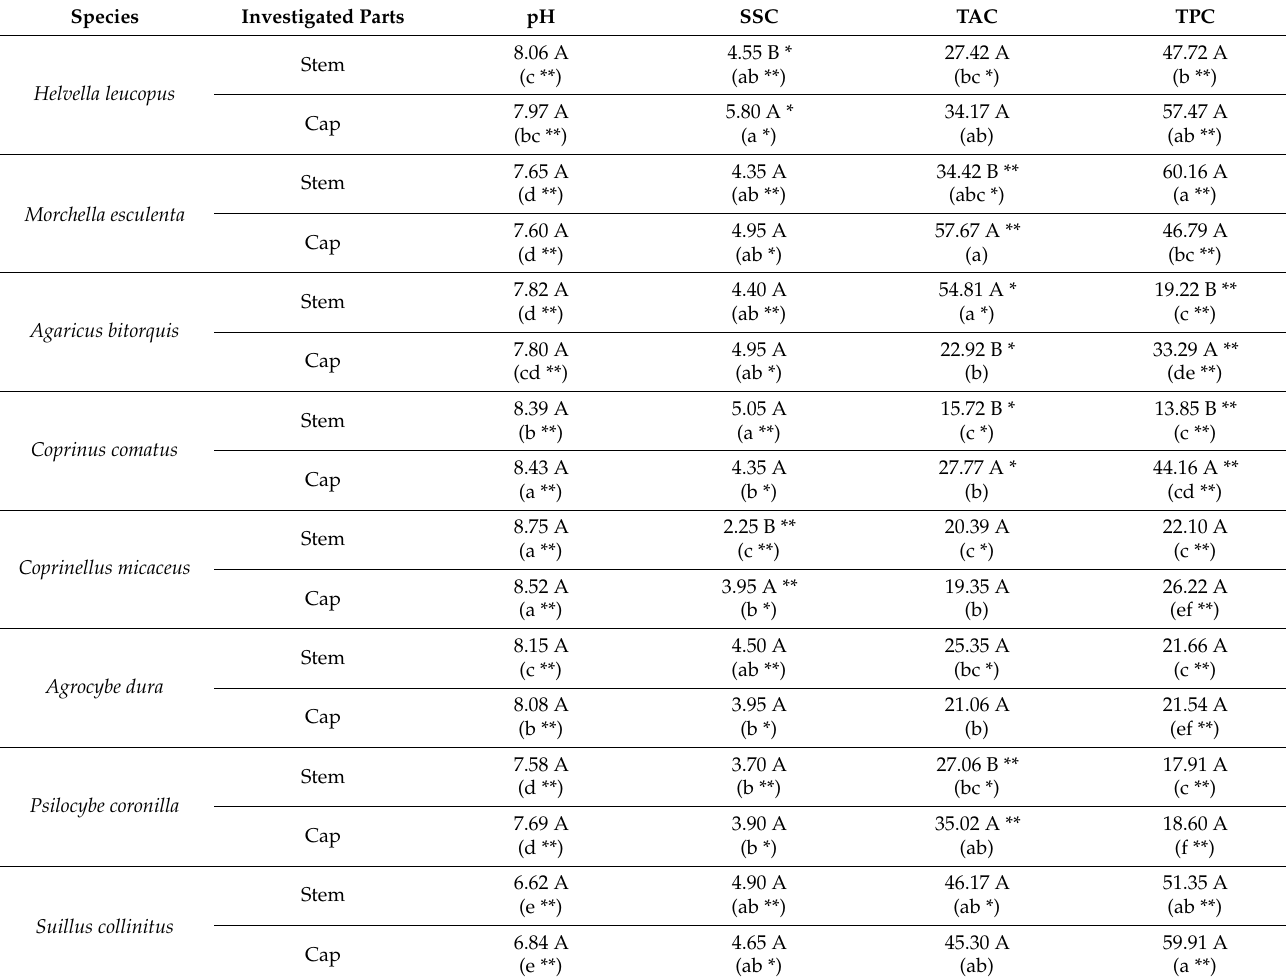
Table 4. Determination of pH, soluble solid contents (SSC ◦ Brix), total antioxidant capacity (TAC µ mol TE g − 1 FW) and total phenolic contents (TPC mg GAE kg − 1 FW) in some naturally grown mushroom species. (FW = Fresh Weight, GAE = Gallic Acid Equivalent, TE = Trolox